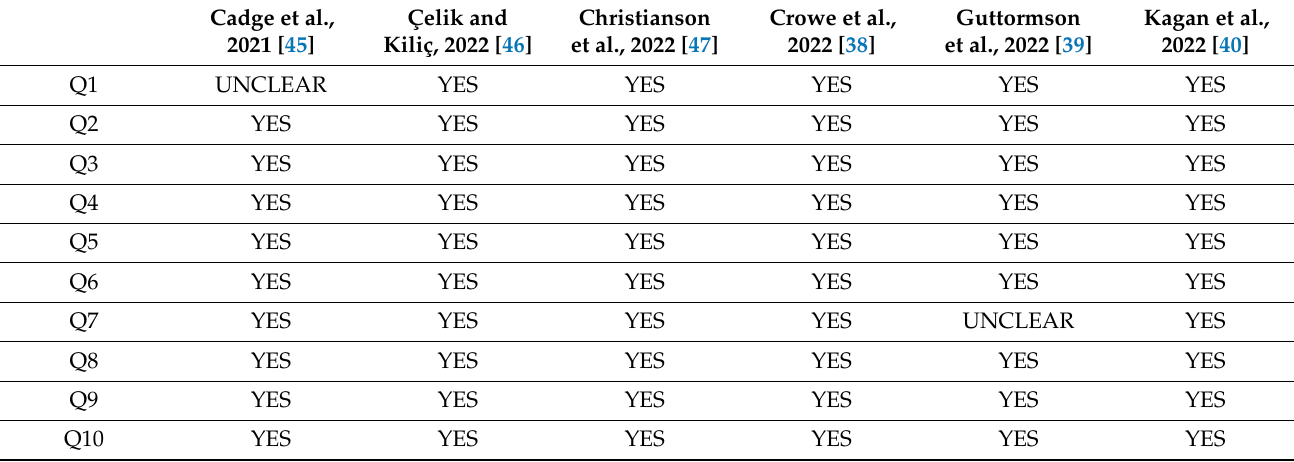
Table 2. Methodological quality assessment of the reviewed studies (qualitative studies/parts). Cadge et